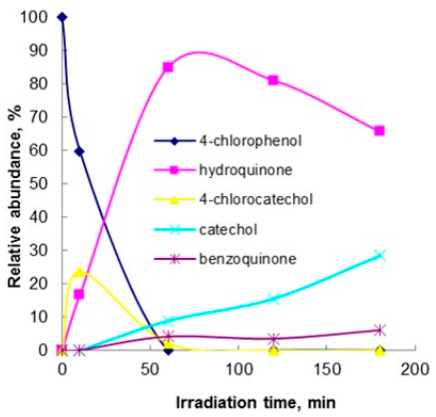
Figure 5. Intermediates identified during the photocatalytic oxidation of 4-chlorophenol working solution of 300 mg O 2 /L.